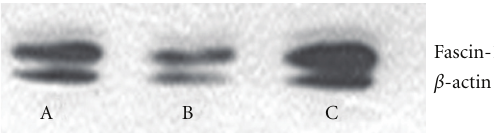
Figure 3: The fascin-1 and β -actin protein expression of DCCIK CIK and K-ras-DCCIK by western blot (experiment 2.6). A, B, and C demonstrate the fascin-1 expression in DCCIK, CIK, and K-ras- DCCIK cultured for 14 days. Compared with group DCCIK and CIK, fascin-1 in K-ras-DCCIK was increasing significantly ( P < 0 . 01). DCCIK versus CIK has statistical significance ( P < 0 . 05). The gray values of the reference protein bands are almost equal. It was shown that β -actin can be stably expressed in the cells.